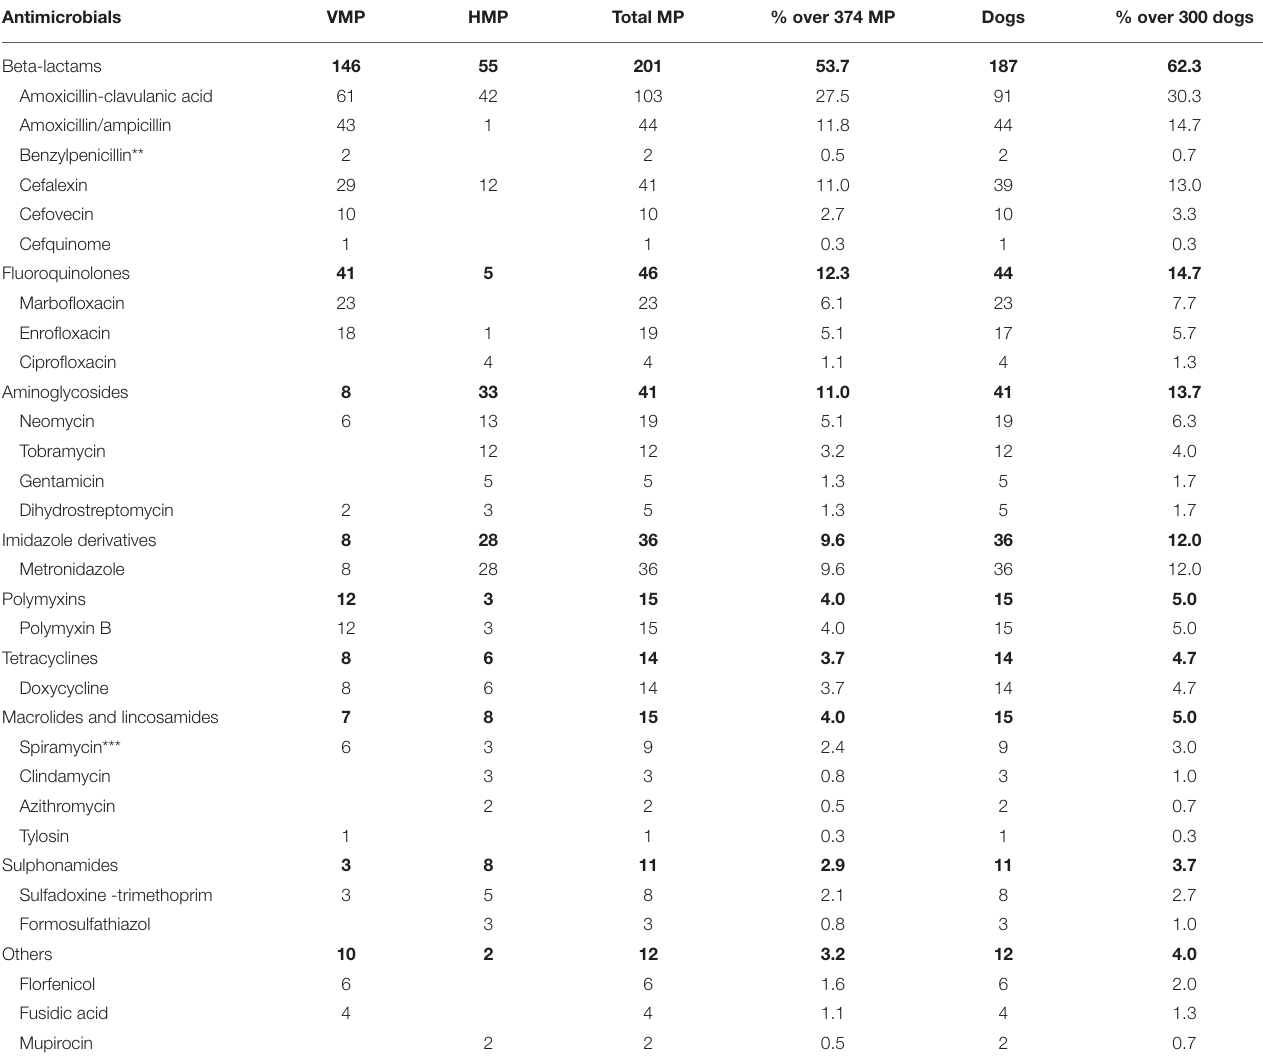
TABLE 1 | Distribution of antimicrobials of 374 medicinal products (MP) prescribed to 300 dogs (Madrid City) according to authorization for Veterinary (VMP) or Human (HMP) use. Antimicrobials VMP HMP Total MP % over 374